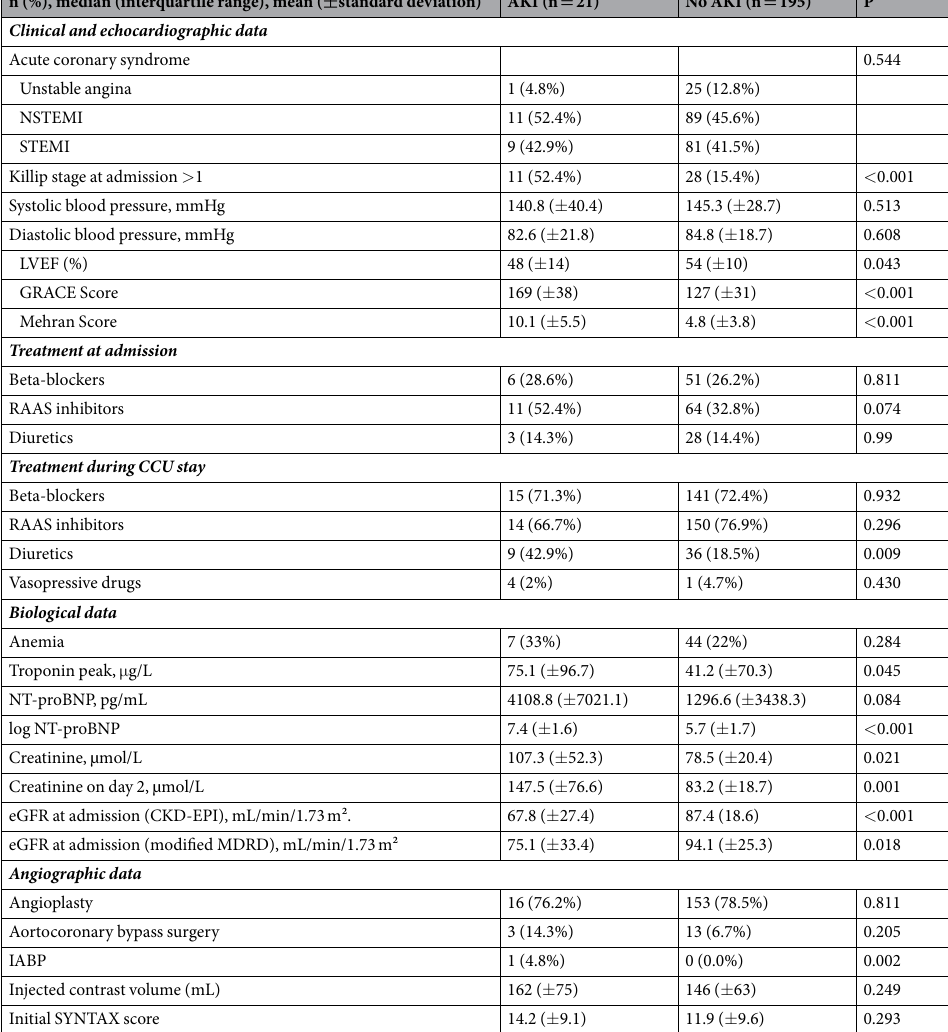
Table 2. Clinical, biological and angiographic data. AKI: acute kidney injury; CCU: coronary care unit; eGFR: estimated glomerular filtration rate; IABP: intra-aortic balloon pump, LVEF: left ventricular ejection fraction; NSTEMI: acute myocardial infarction without ST segment elevation; NT-proBNP: N terminal pro-brain natriuretic peptide; RAAS: renin-angiotensin-aldosterone system; STEMI: acute myocardial infarction with ST